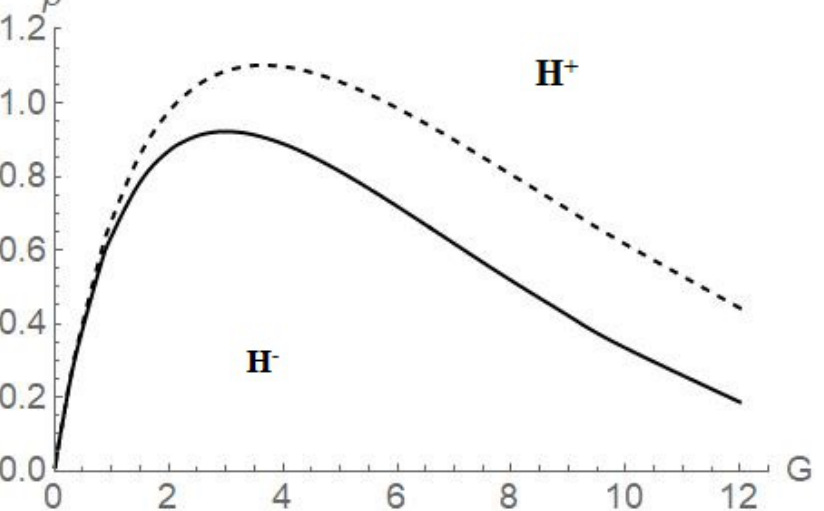
Figure 3. Pattern selection for regular hexagons ( q 0 = 0). Solid line: s 1 ( G , β ) = 0 in the case without surfactant ( N = 0), the dashed line: in the case with surfactant ( N = 10 − 6 , L = 0.003). Up-hexagons ( H + ) are selected in the region above the line s 1 = 0, and down-hexagons ( H − ) are selected below that